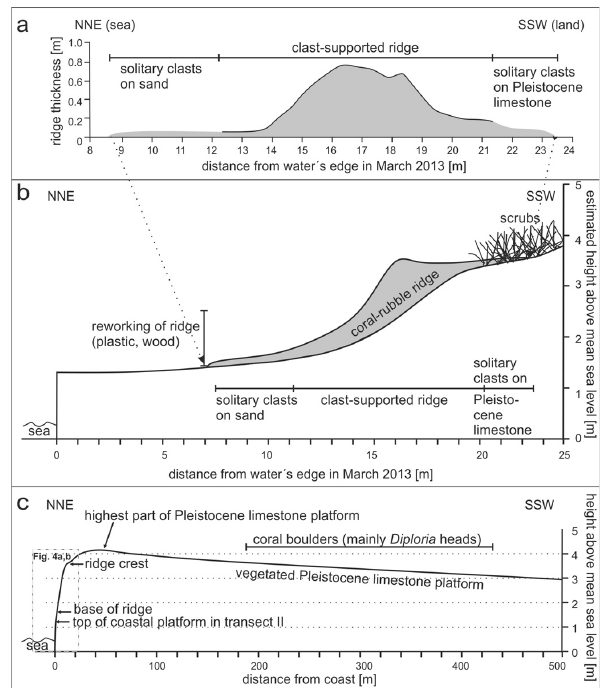
Fig. 4. (a) Schematic cross section of transect II depicting thickness and morphology of the ridge without underlying topography. Note that the ridge lies on top of a ca. 1.3m high limestone platform. (b) Schematic topographic profile showing the onlap of the coral- rubble ridge onto the Pleistocene platform. (c) Topographic cross section reaching from the shore onto the limestone platform. Coral boulders are strewn on top of the platform between about 200– 450m from the shore (after: Weil Accardo et al., 2012; Fig.